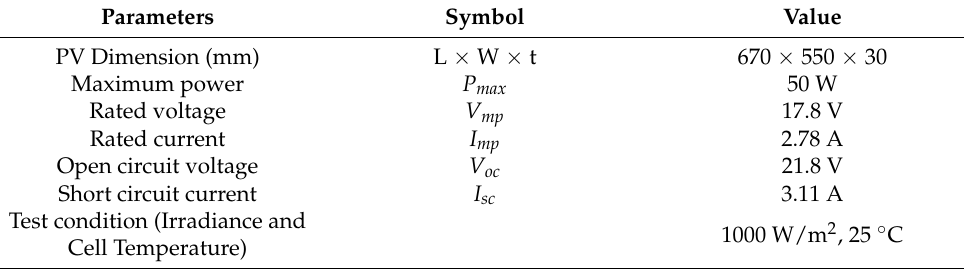
Figure 1. ( a ) Copper multi-pipe cooling frame, ( b ) PV integrated with passive cooling system. Table 1. Specification of the PV modules supplied by the manufacturer.